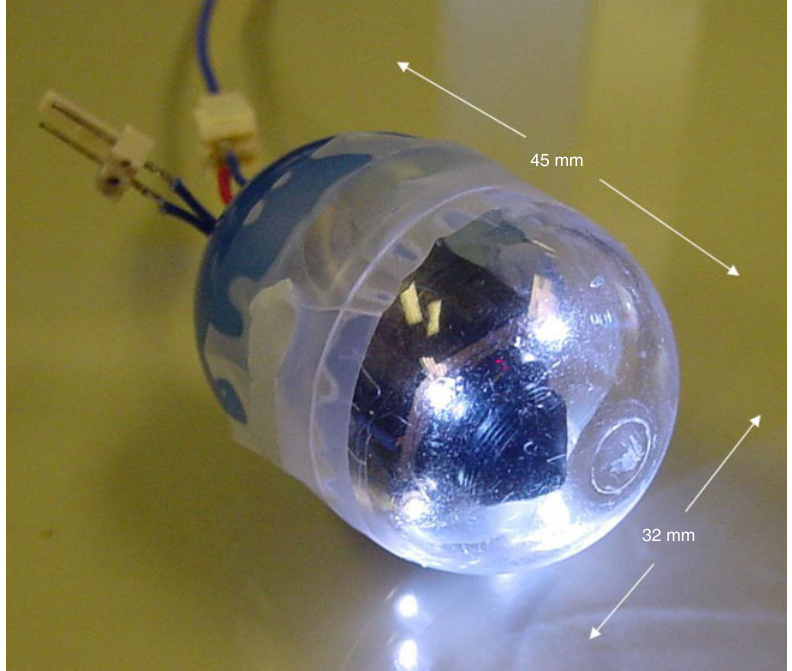
Figure 10 The stand-alone system – the encased WCE